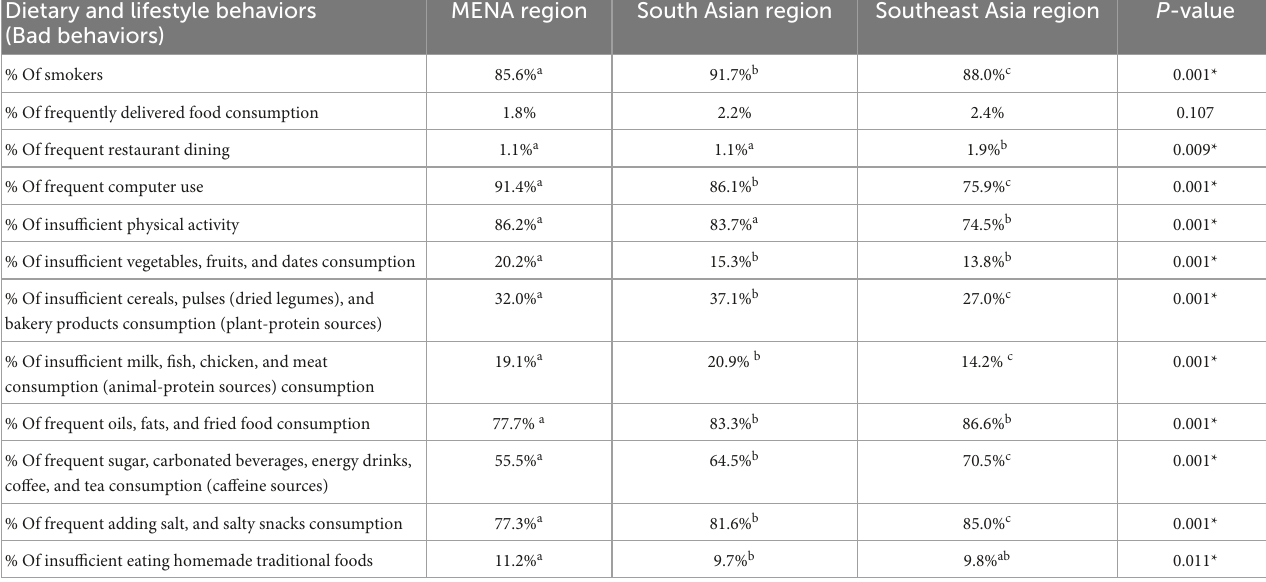
TABLE 7 Comparison between the three regions (during